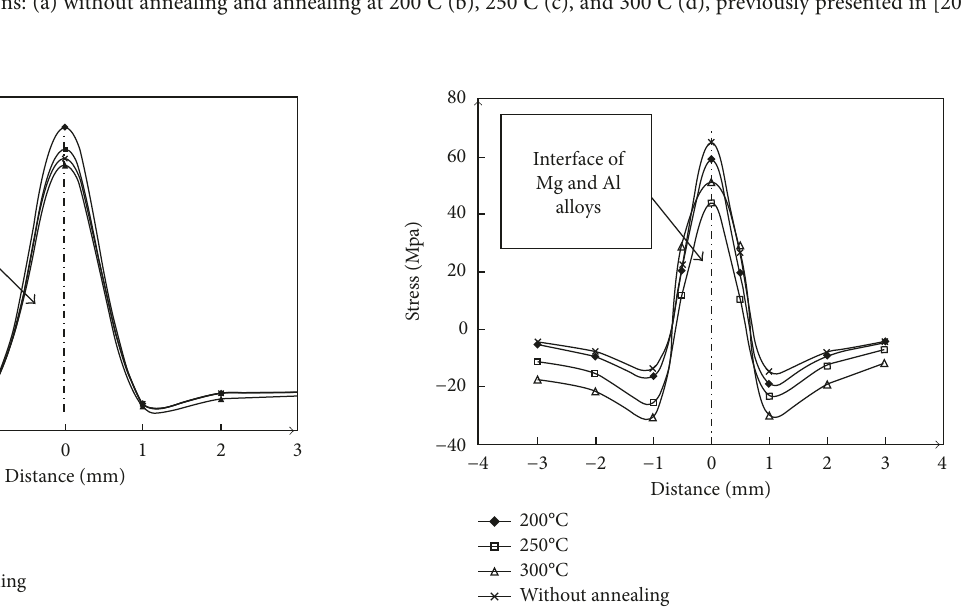
Figure 4: Distribution of residual stress obtained by simulation, previously presented in [20].